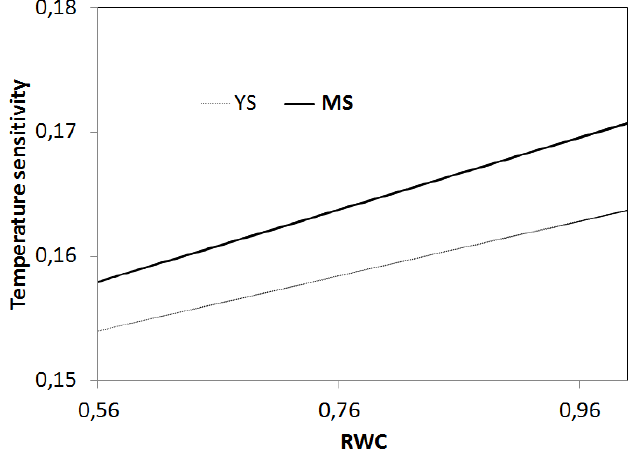
Figure 7. Dependency of temperature sensitivity of respiration on relative water content (RWC). The thin line corresponds to soil respiration in the young stand (YS) and the thick line corresponds to soil respiration in the mature stand